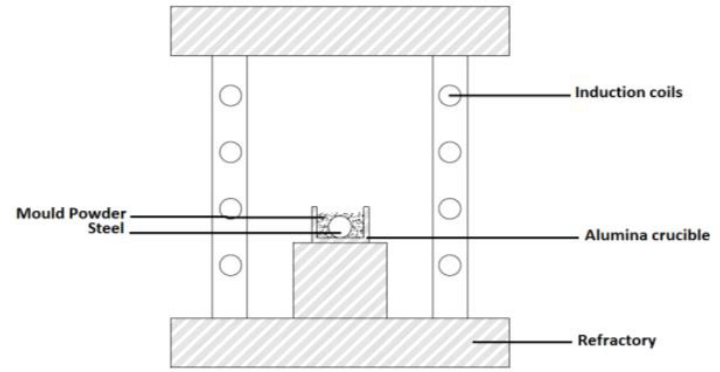
Figure 6. Schematic of steel–slag interaction test setup.